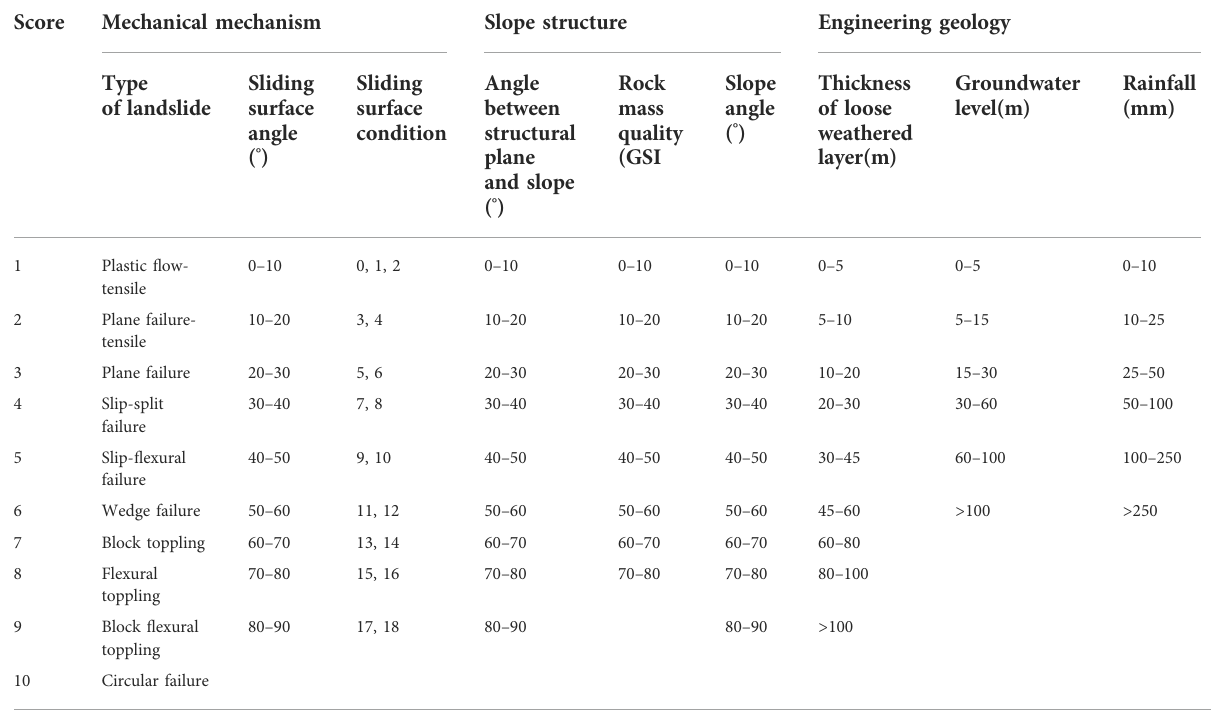
TABLE 3 Reference score of the landslide